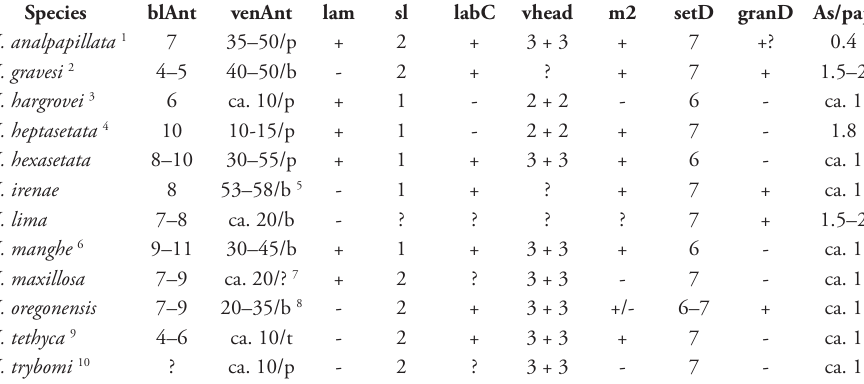
Table 1. Morphological differences between the members of the trybomi group. Data after: H. anal- papillata – Jiang and Yin (2012); H. hargrovei – Skarżyński (2007); H. gravesi – Bernard (2015); H. heptasetata – Jiang and Yin (2010); H. hexasetata – Jiang and Yin (2010); H. irenae – Bernard (2015); H. lima – Christiansen and Bellinger (1998), Skarżyński (2007); H. manghe – Jia et al. (2011); H. maxillosa – Babenko et al. (1994); H. oregonensis – Yosii (1960), Fjellberg (1985), Babenko et al. (1994),